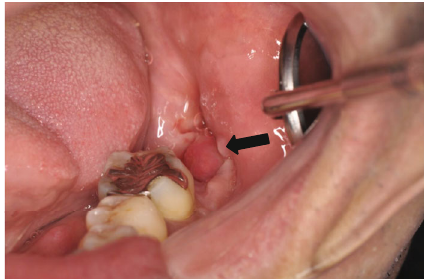
Figure 3: Reddish granular tissue that easily bleeds is observed protruding from the mesial wall of the extraction socket of the second mandible (arrow).